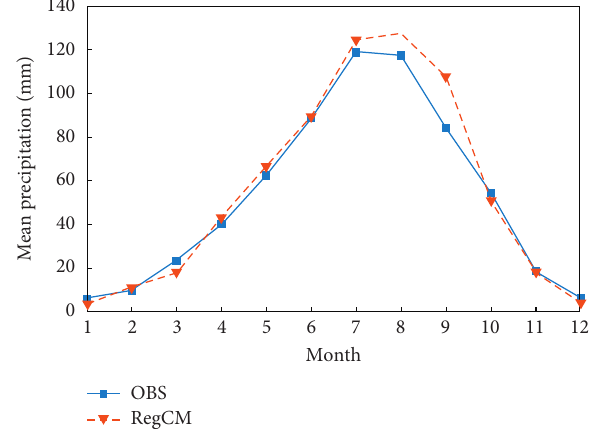
Figure 3: Intra-annual distribution of monthly mean precipitation as obtained from observations and simulation for 1986–2005 for Shaanxi